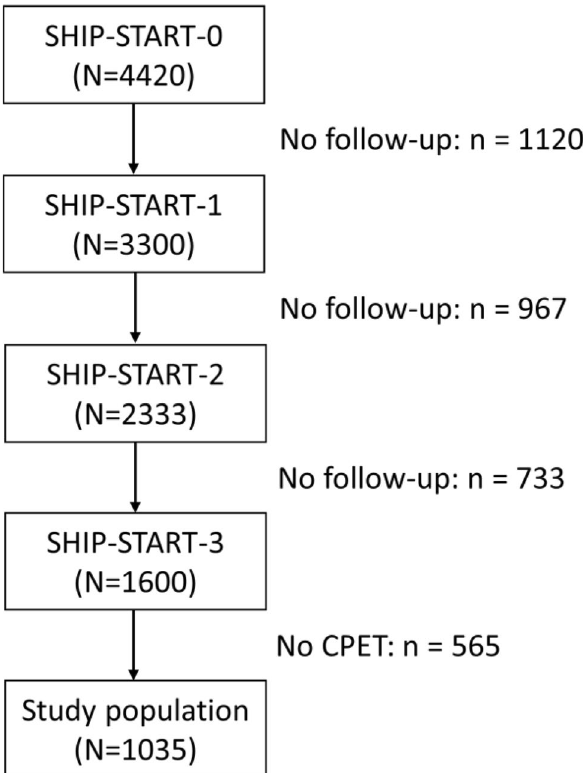
Figure 1. PRISM diagram about the selection of